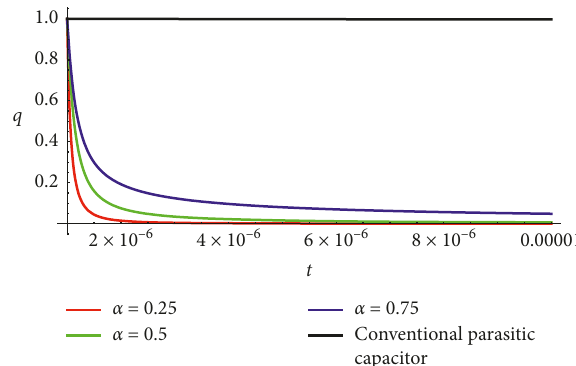
Figure 4: q vs t of the memristor affected by the parasitic fractional capacitor and by the conventional parasitic capacitor [9].